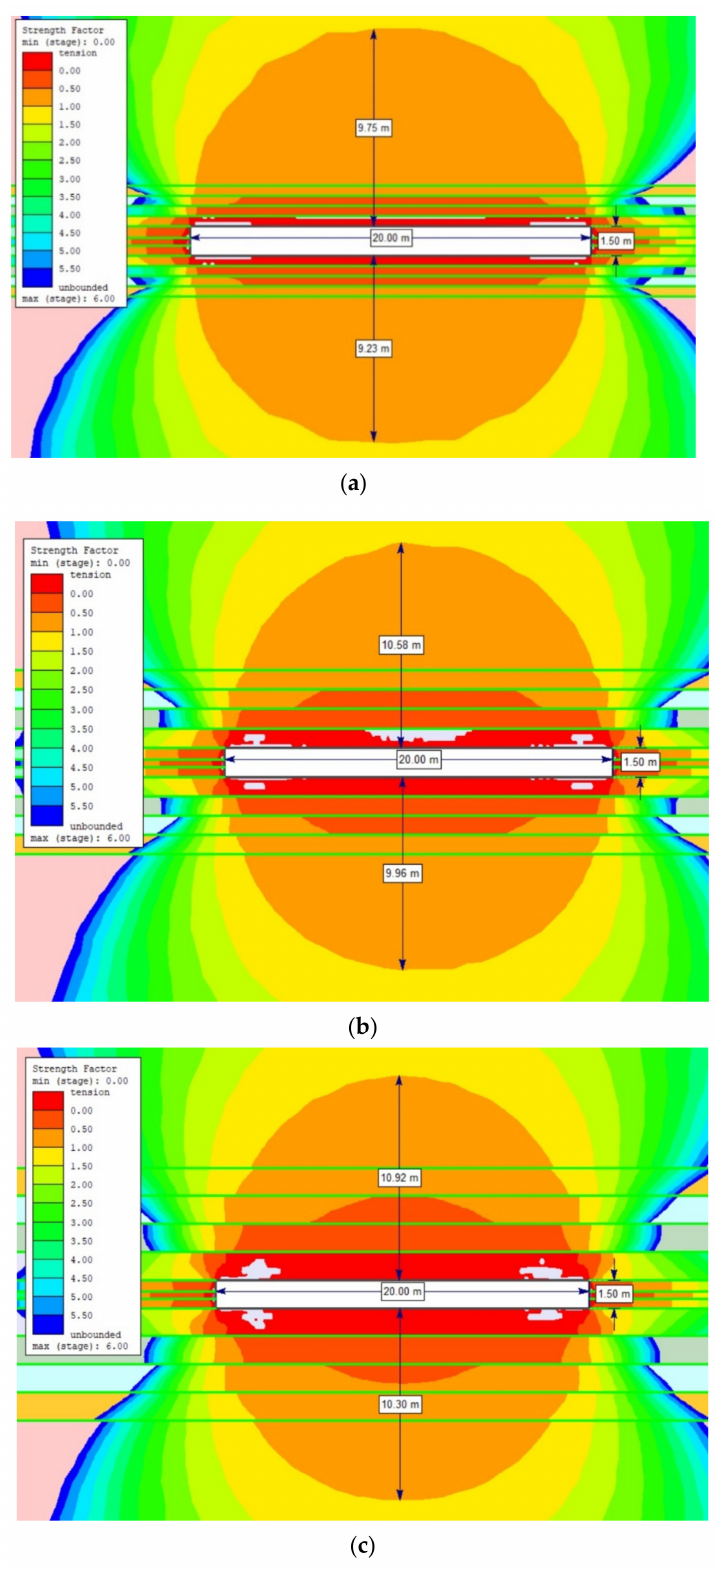
Figure 15. The extent of the rock destruction zone around the gasification channel with a width of 20 m and the impact of temperature of 1200 ◦ C for the wet rock mass, up to the height of: ( a ) 0.5 m; ( b ) 1.0 m; ( c ) 1.5